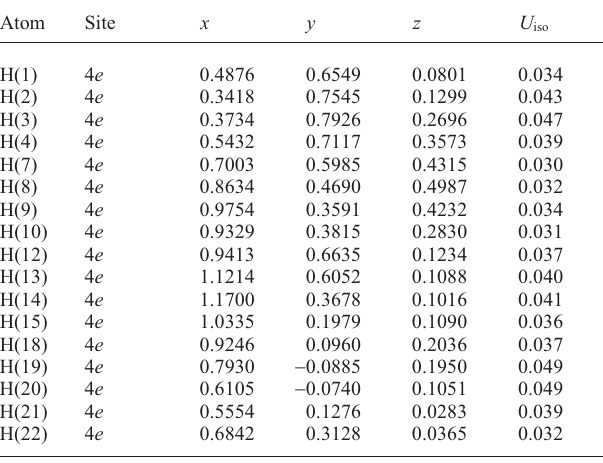
Table 2. Atomic coordinates and displacement parameters (in Å 2 )